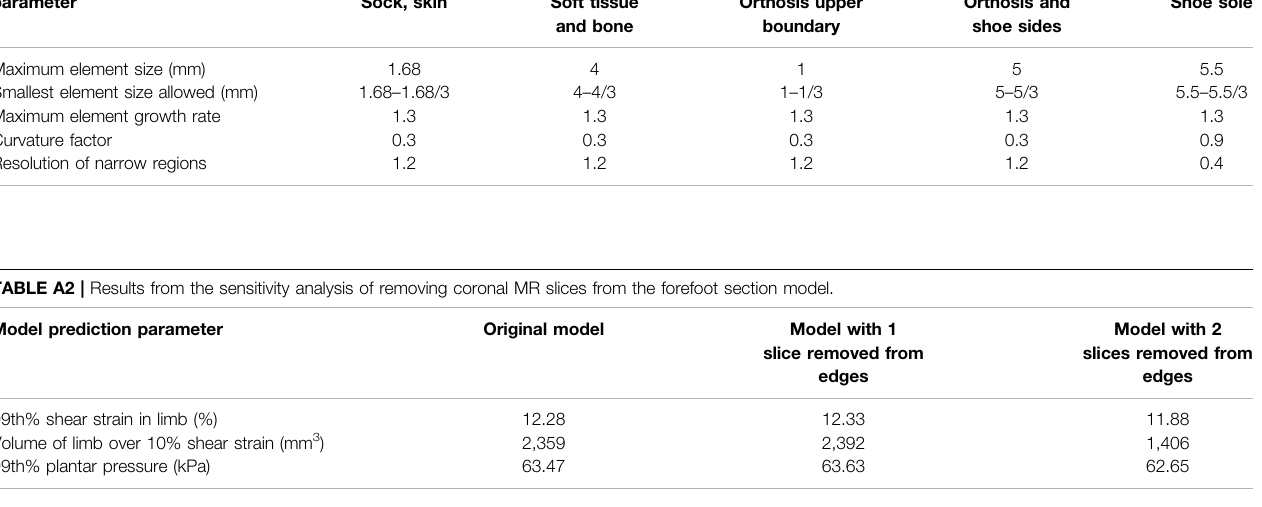
Region 5: Shoe sole